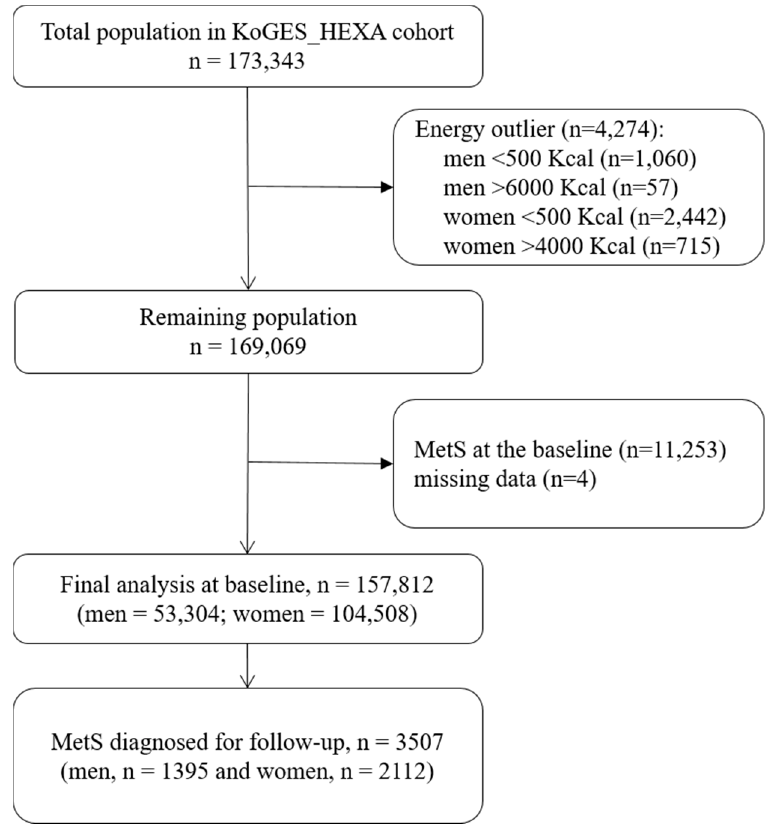
Figure 1. Flowchart of Korean Genome and Epidemiological Studies Health Examination (KoGES_HEXA) cohort participants included in the main analysis. MetS: Metabolic Syndrome.